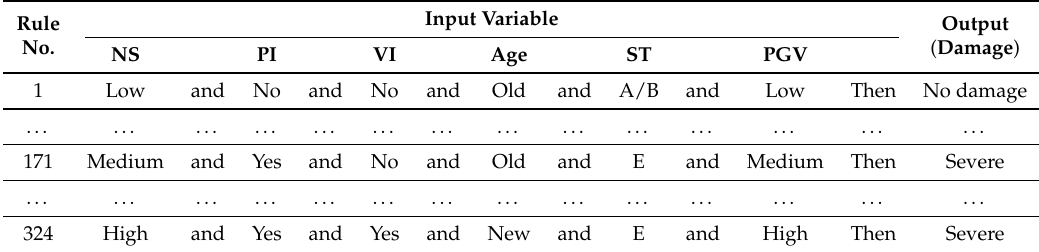
Figure 3. Generalized bell-shaped membership functions for damage as output variable. Table 2. The structure of the T2FLS in this